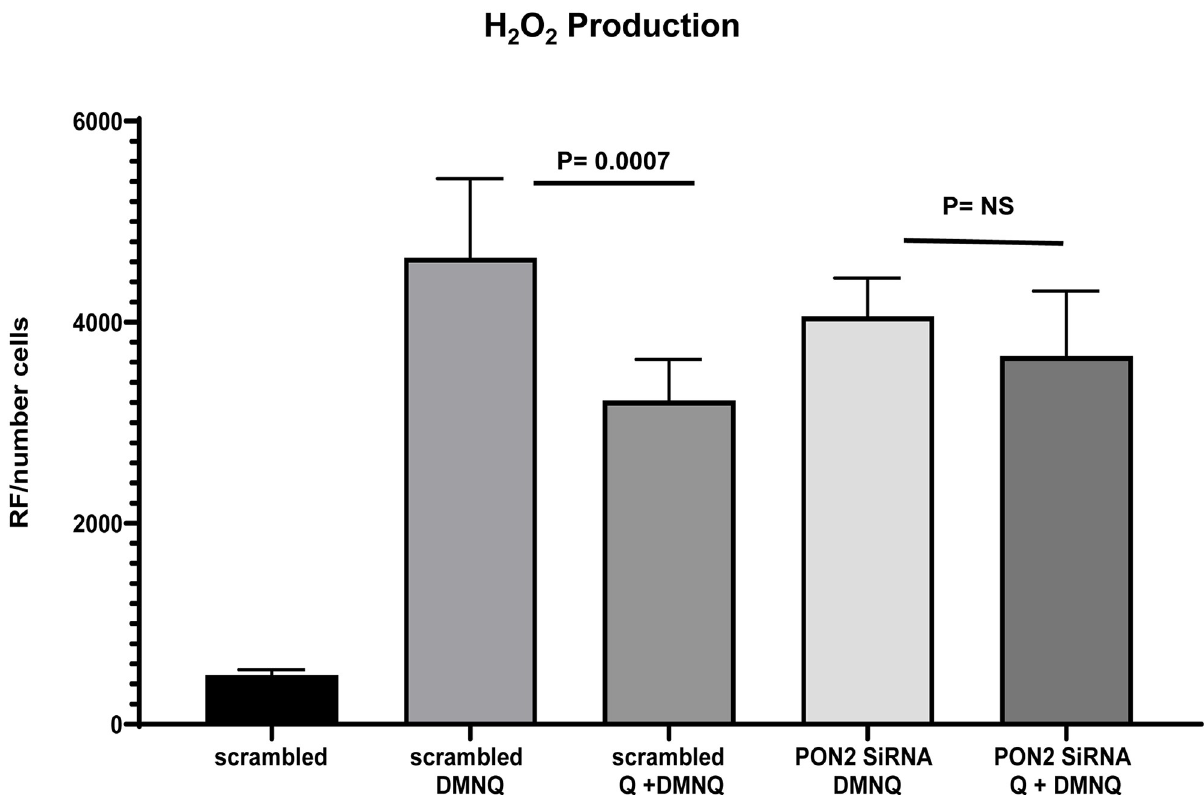
Fig 8. PON2 knockdown rendered cells more susceptible to oxidative stress. The oxidative stress response in siRNA transfected BEAS2B cells treated with quercetin. BEAS2B transfected cells were pretreated for 24 hs with 25 μ M quercetin. After washout, cells were exposed for 20 minutes to 25 μ M DMNQ. H 2 O 2 production was measured by Amplex Red p < 0.0007, N = 5/group.one-way